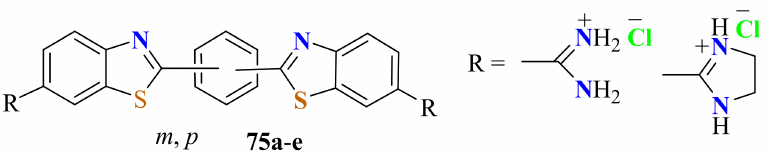
Figure 9. Condensation of isophthaloyl and terephthaloyl dichlorides with 4-substitutes ATP thiolate to afford